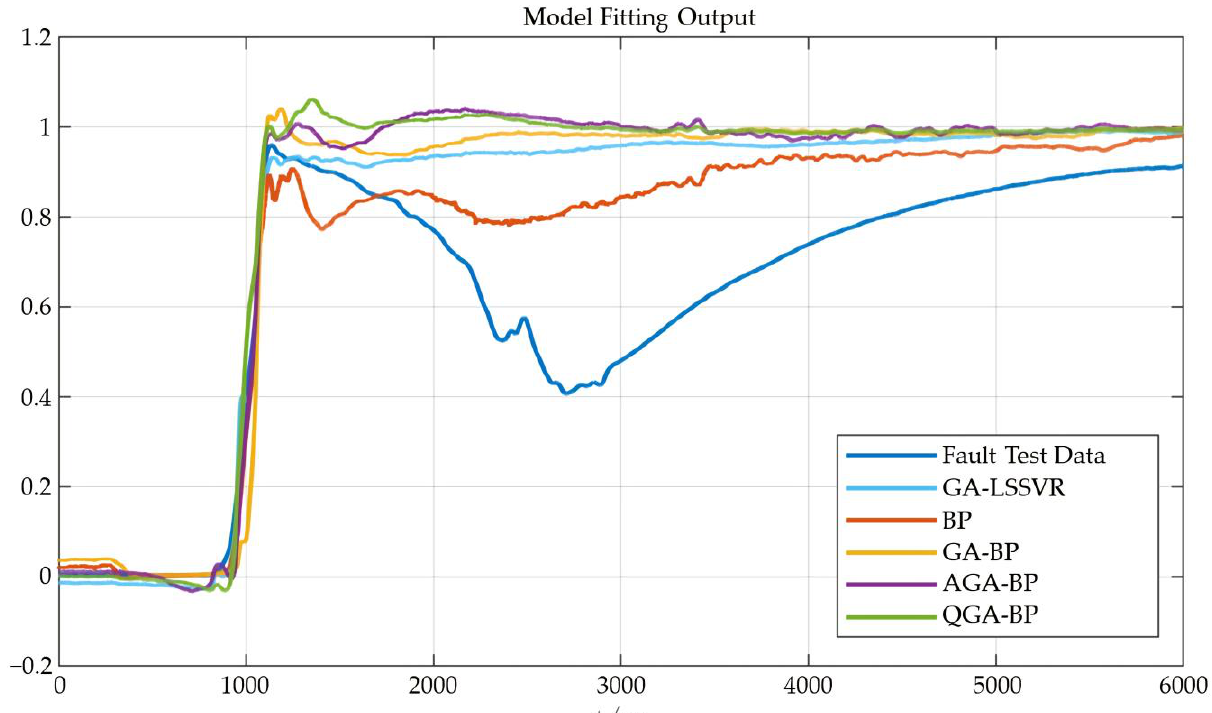
Figure 8. BP, GA-BP, AGA-BP, QGA-BP, GA-LSSVR fitting output: fault test data.